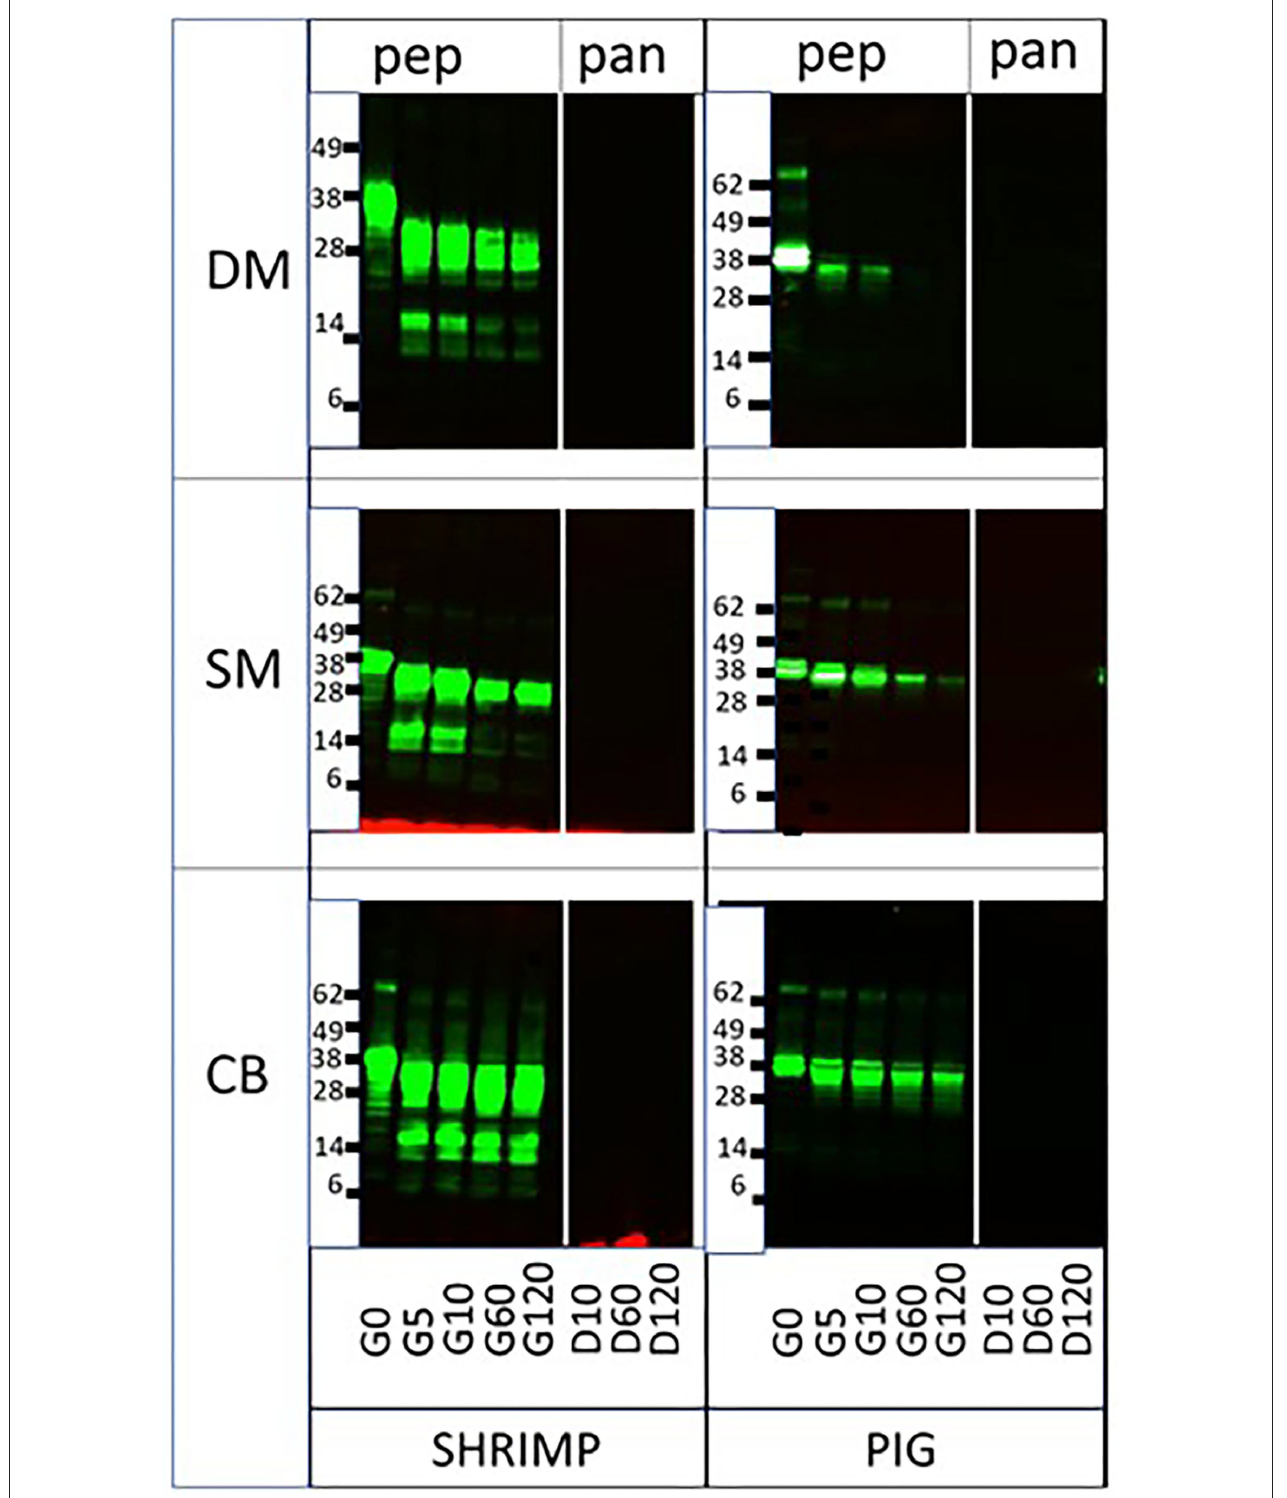
FIGURE 1 | Sequential pepsin-pancreatin digestion of shrimp and porcine tropomyosin in three matrices. DM, dessert mousse; SM, soy milk; CB, chocolate bar, pep, pepsin; pan, pancreatin. Samples were taken at the start of pepsin digestion (G [gastric] 0) and at 5 (G5), 10 (G10), 60 (G60), and 120 (G120) min, and at 10 (D [duodenal] 10), 60 (D60), and 120 (D120) min of subsequent duodenal digestion. Samples were analyzed by immunoblot with respective tropomyosin-specific antibodies. Molecular weight markers are indicated on the side in kDa.